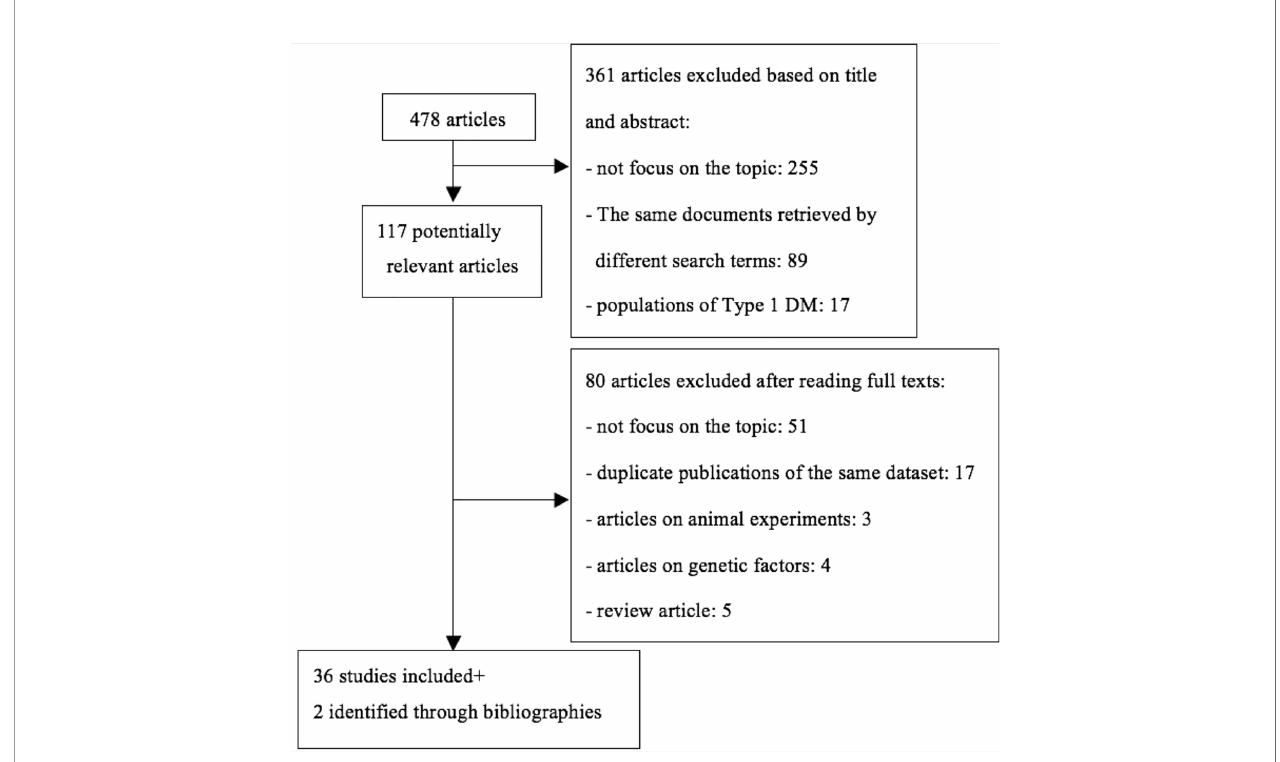
FIGURE 1 | Summary of literature